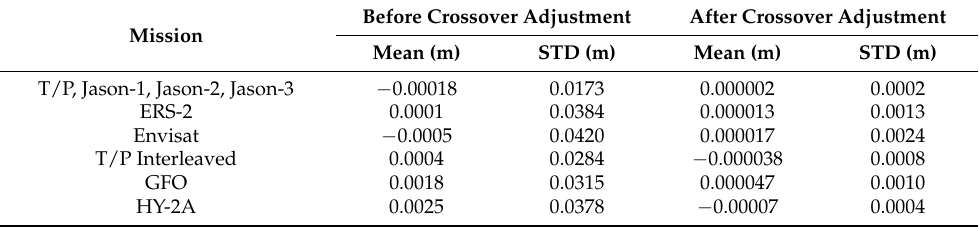
Table 3. The results of crossover differences of SSH before and after the crossover adjustment. Before Crossover Adjustment After Crossover Mission